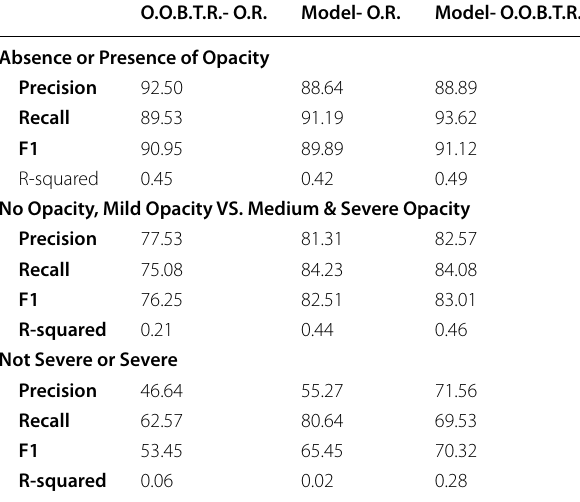
Table 7 Output comparison between final model, OR (Original Reader), and OOBTR (Out Of Box Test Reader). Model output compared with OOBTR and OR using multiple evaluation metrics for multiple binary classifications with binary output classes derived from the original multiclass output